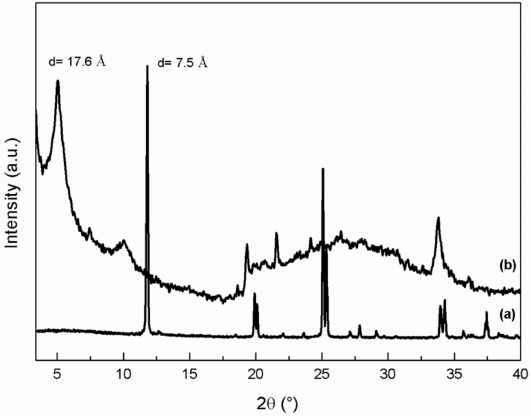
Figure 2. XRPD patterns of ZrP ( a ) and ZrP-GTM intercalation compound ( b ).